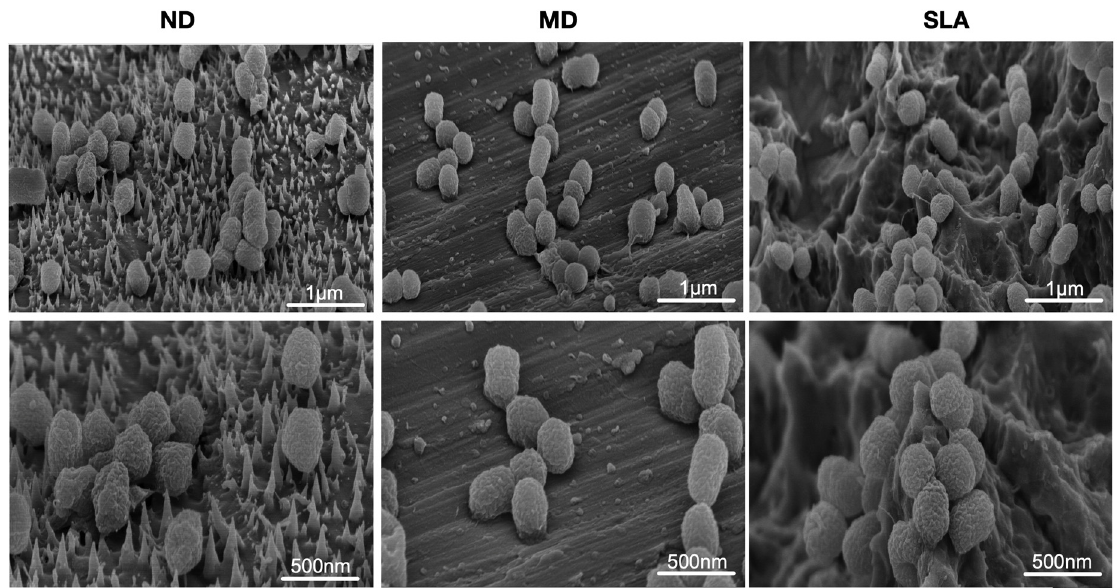
Figure 4. ( A ) SEM scans of different titanium discs following incubation for 6 h with P. gingivalis cultures. The three top panels have bars indicating 1 μ m for ND, MD, and SLA; the three panels at the bottom have bars indicating 500 nm for ND, MD, and SLA. All specimens were occupied by clusters of P. gingivalis . Additionally, P. gingivalis showed dysmorphism on ND. Table 2. Table representing mean CFU/disc following P. gingivalis exposure for possible bacterial adhesion on ND, MD, and SLA, for five replicates. ND showed a reduction of 17% and 20% compared to MD and SLA,